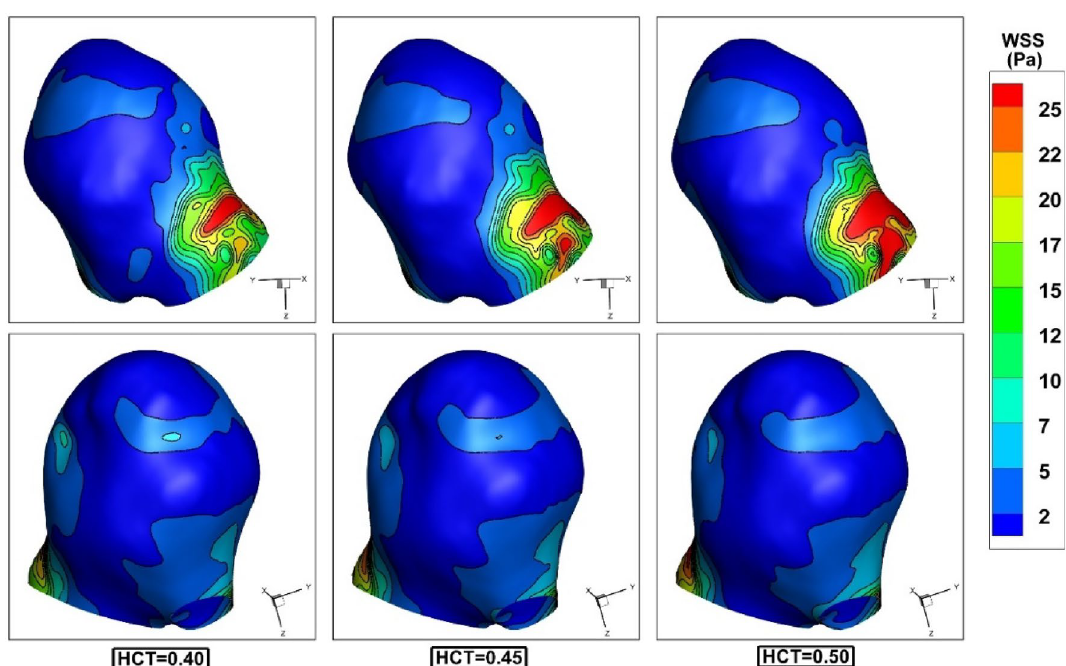
Figure 8. Effects of hematocrit on the WSS distribution at peak